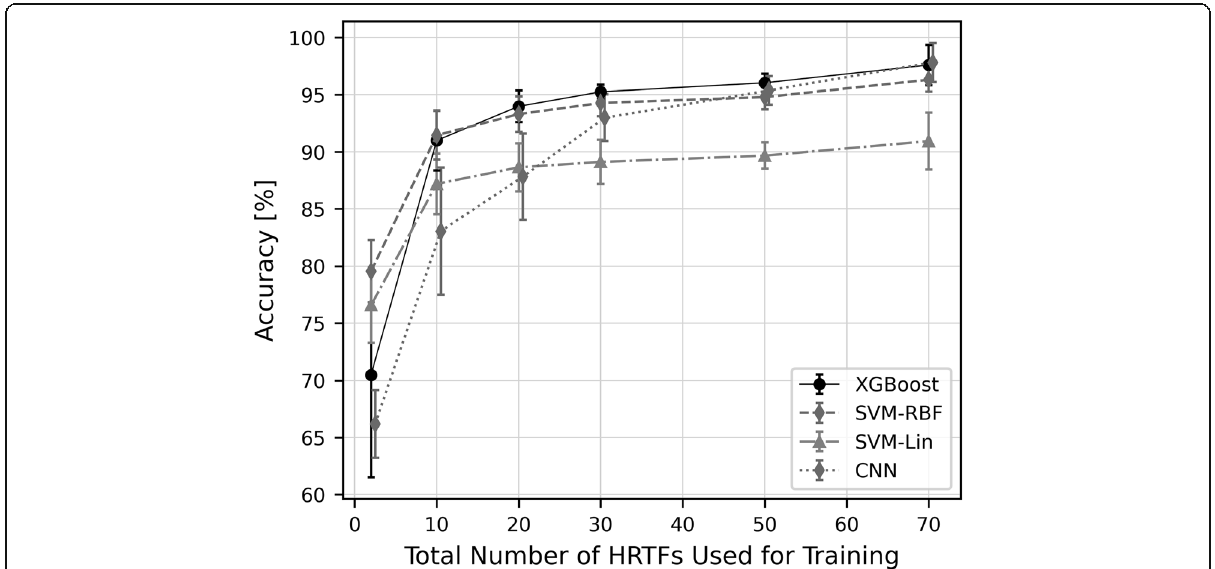
Fig. 15 Discrimination mean accuracy scores obtained under HRTF-independent test as a function of the total number of HRTFs used for training. Error bars denote standard deviations